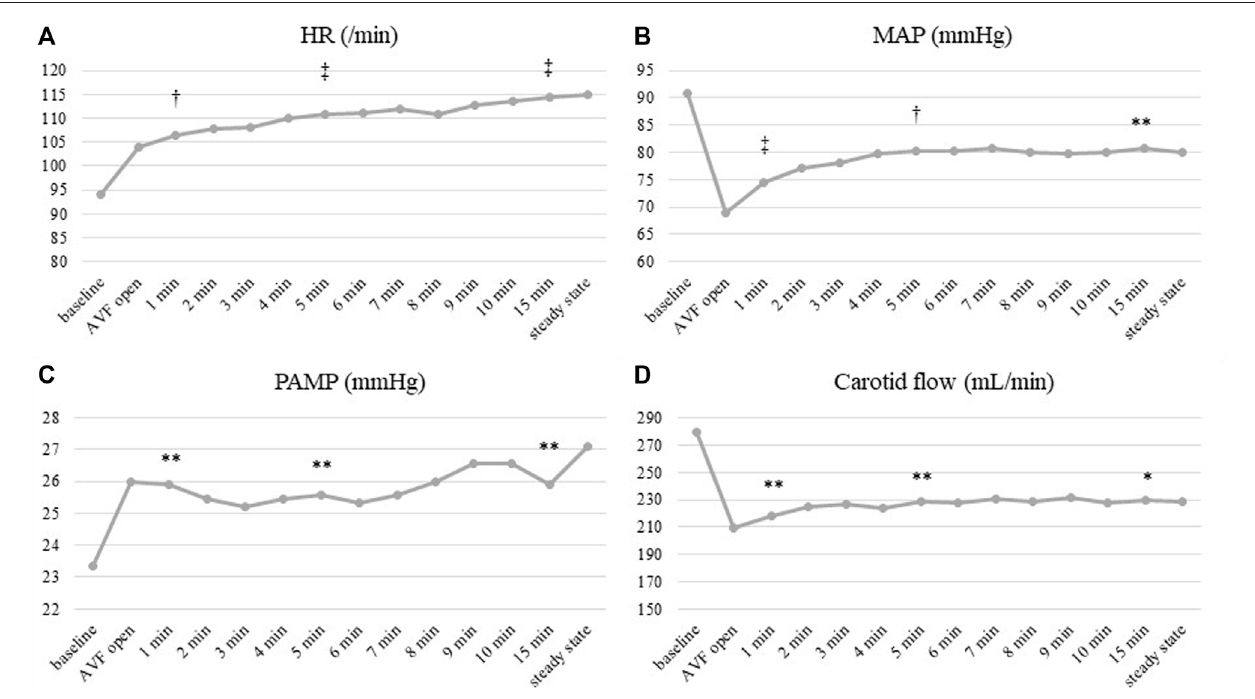
FIGURE 4 | Time course of hemodynamic parameters after AVF opening. (A) Heart rate, (B) Mean arterial pressure (MAP), (C) Pulmonary artery mean pressure (PAMP), (D) Carotid artery fl ow. HR and PAMP (A,C) increased immediately after AVF opening and showed a continuous increase afterwards. MAP and carotid artery fl ow (B,D) dropped rapidly, then rose after the initial dip; the resulting values remained lower than in baseline. Signi fi cance of observed changes after AVF opening vs . baselines was calculated at 1, 5 and 15 min after AVF opening. Displayed values are averaged from all subjects. * p < 0.05; ** p < 0.01; † p < 0.001; ‡ p < 0.0001.